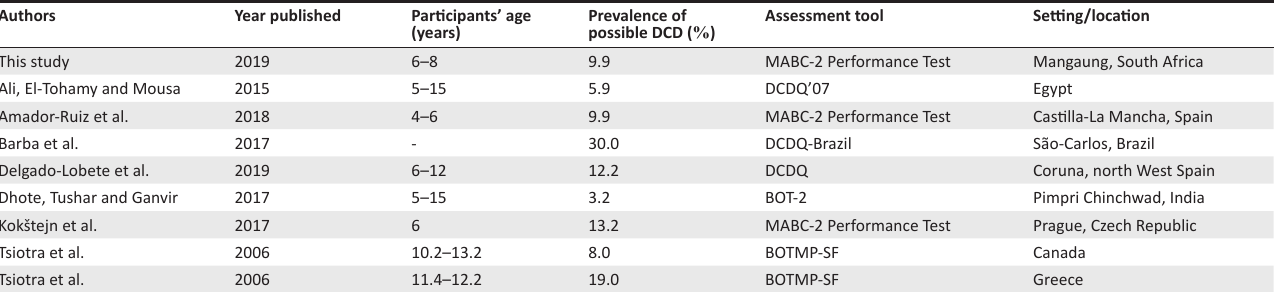
TABLE 6: Comparison of this study with previously reported findings on the prevalence of developmental coordination disorder in different countries, with socio-economic environment not taken into account.